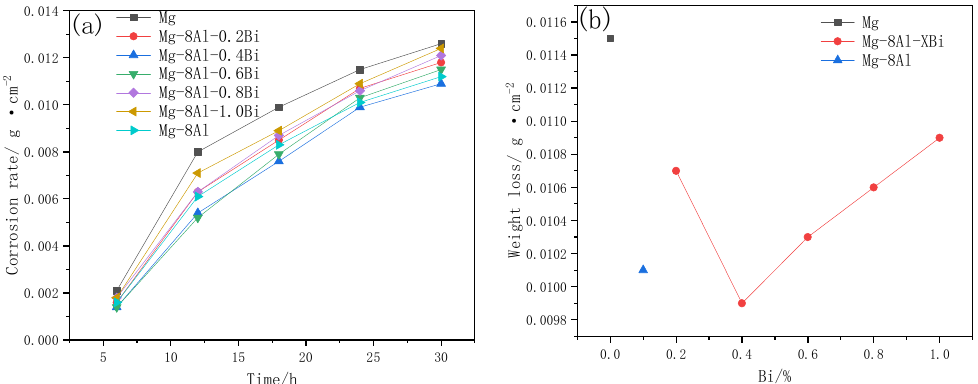
Figure 9. ( a ) Corrosion rate–time curves of Mg–8%Al–xBi alloys measured in 3.5% NaCl solution. ( b ) Weight loss–Bi content of Mg–8%Al–xBi alloys soaked in 3.5% NaCl solution for 24h.